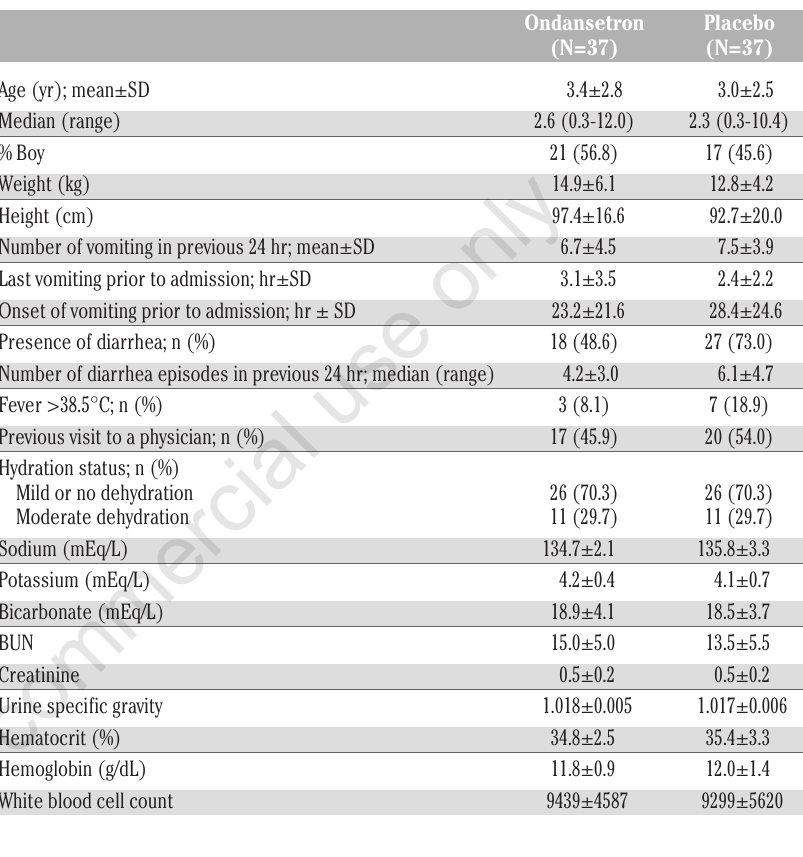
Table 2. Demographic description of ondansetron and placebo groups.